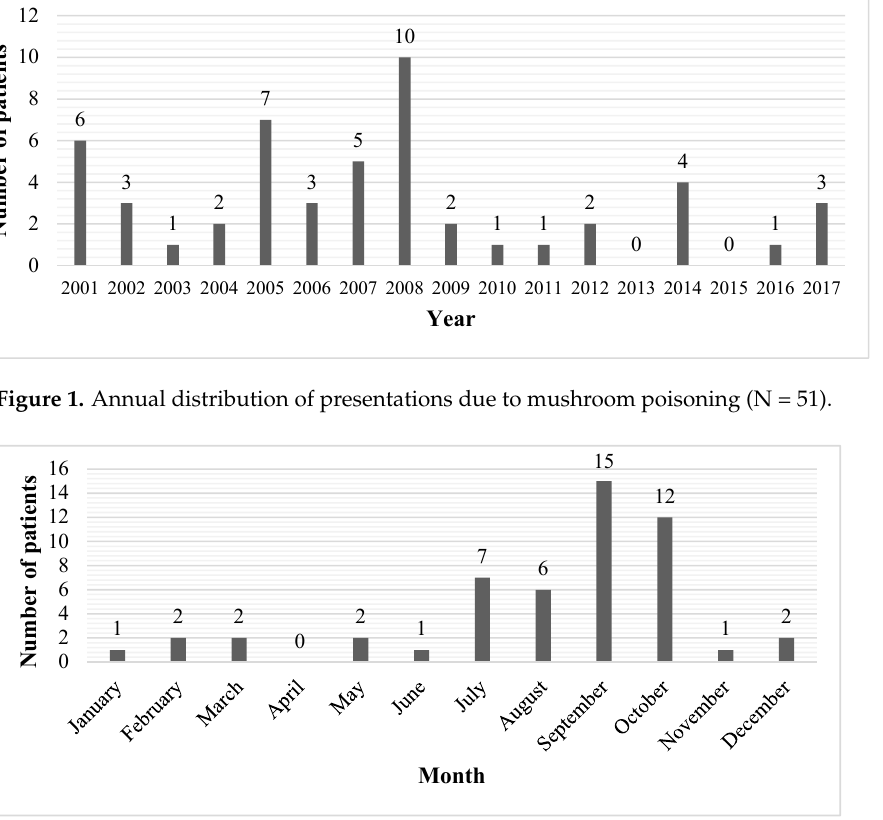
Figure 2. Monthly distribution of presentations for mushroom poisoning (N = 51; bars represent the sum of patients presenting during the same month throughout the study period).